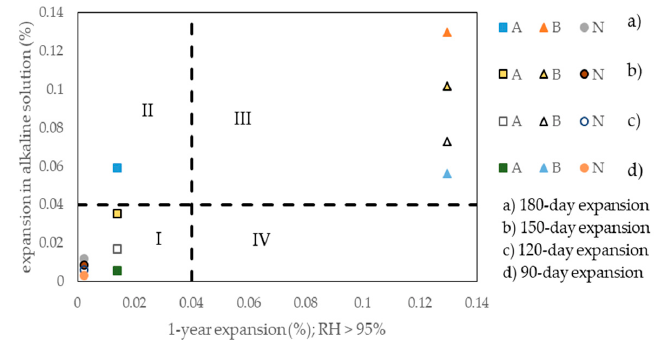
Figure 5. Comparison between the reactivity diagnoses for the three aggregates tested with the traditional CPT and the accelerated CPT using different expansion limit